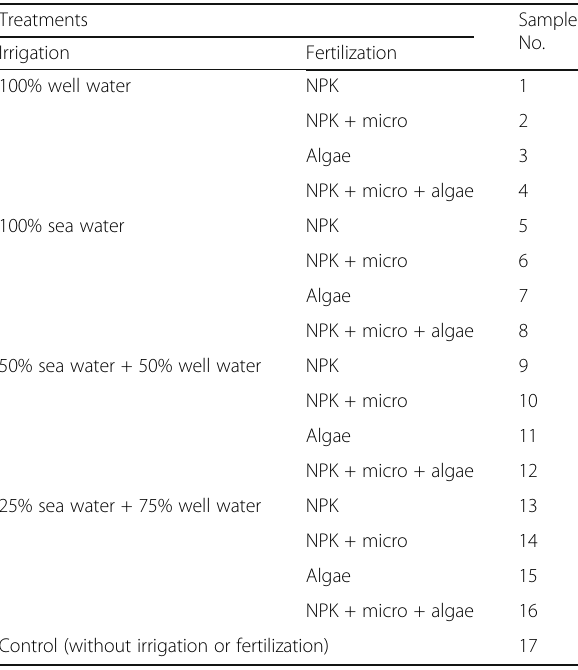
Table 1 Samples key under different combined treatments of fertilization and irrigation Treatments Sample